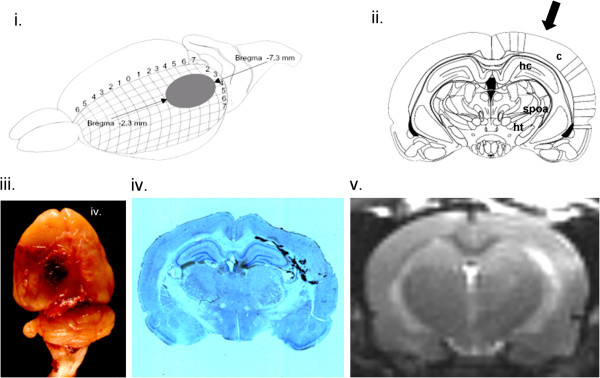
Traumatic brain injury via lateral fluid-percussion (LFP). The lesion inflicted via LFP is typically located between Bregma −2,3 mm and −7,3 mm (i.). Injured regions include the ipsilateral cortex (c) but also deeper brain/brain stem structures such as hippocampal (hc), thalamic, hypothalamic (ht), pontine, and supraoptic areas (spoa) (ii.; coronar section of the brain at Bregma −4,52; arrow indicates direction of impact). The model used for this experiment reproducible creates a subdural haematoma (iii.), focal cortical contusion ipsilateral to the injured site of the brain with a characteristic pattern of haemorrhage involving subcortical white matter, adjunct cortex, subarachnoid space, hippocampus as well as deep brain structures such as thalamus, hypothalamus and pontine regions (iv.; Nissl staining), and a mass shift towards the contralateral hemisphere as a consequence of the trauma-induced ipsilateral cytotoxic/vasogenic edema (v.; T-2-weighted MRI). (modified from [31]; see also “The Rat Brain in Stereotaxic Coordinates” by Praxinos and Watson; Academic Press, 1998).